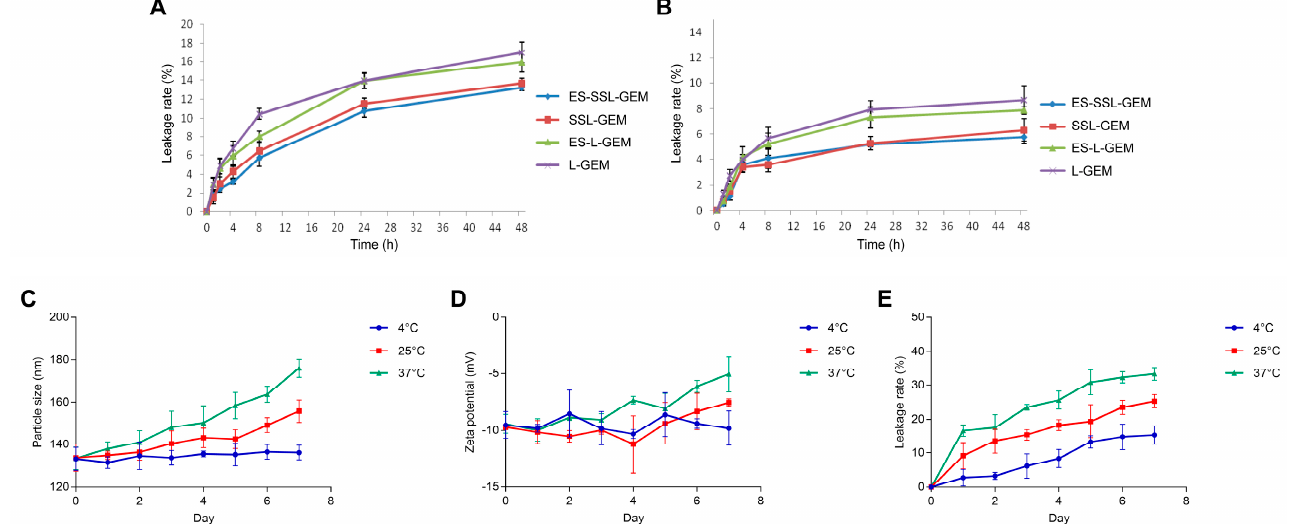
Figure 3. The stability of GEM liposomal formulations. The leakage rate of four GEM liposomes at ( A ) 25 ◦ C and ( B ) 4 ◦ C for 48 h. ( C ) Particle size, ( D ) zeta potential, and ( E ) leakage rate of ES-SSL-GEM stored at 4 ◦ C, 25 ◦ C, and 37 ◦ C for one week.